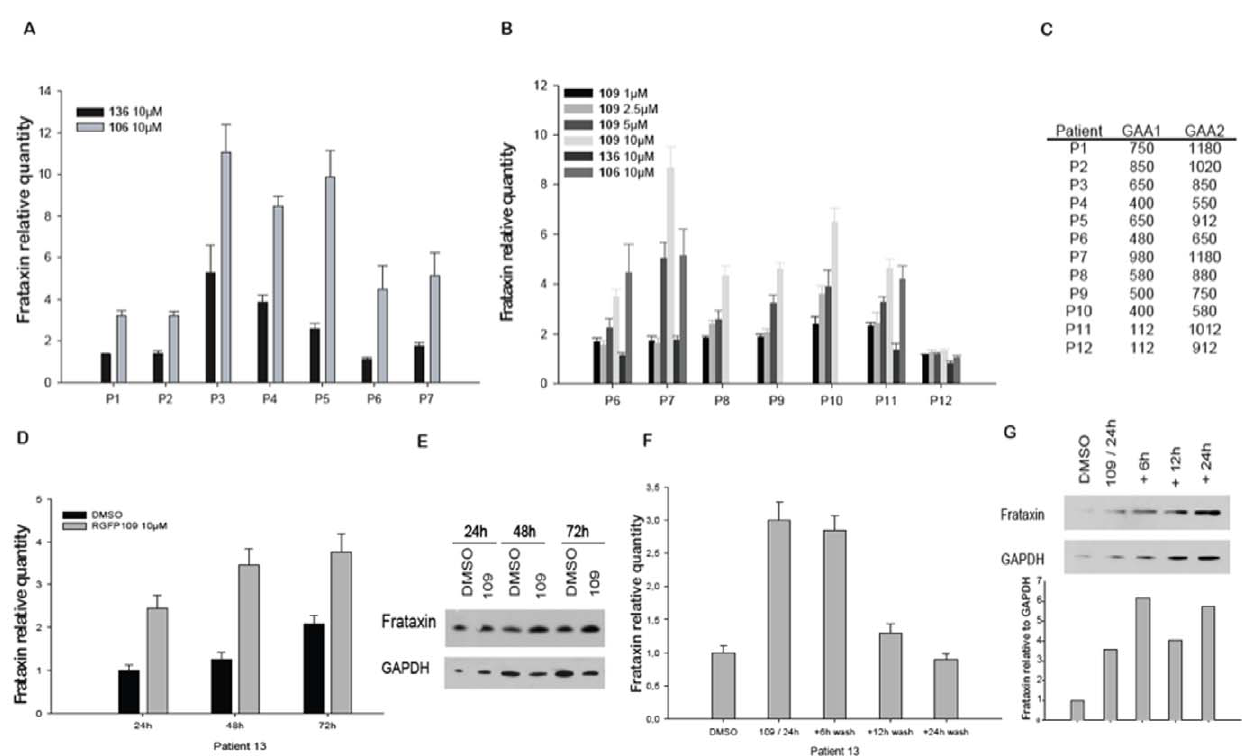
Figure 2. Effect of compounds 136 and 109 on FRDA patients’ primary lymphocytes. A. FXN mRNA levels were measured in RNA from isolated PBMCs from patients (P1–P7) after a 48-hour incubation with either 136 or 106 at 10 m M or DMSO (at 0.1%). Quantitative real-time RT-PCR was used to determine relative FXN levels for each patient condition using GAPDH as a control housekeeping gene. DMSO condition was set to value 1 for each patient. Error is represented as the standard deviation of the mean from 3 determinations. p , 0.001 in all tested patients with compound 106 . Primary lymphocytes were obtained from donor blood from FRDA patients as described [8]. B. FXN mRNA measurement by quantitative real- time RT-PCR in RNA from isolated PBMCs from patients (P6–P12) after a 48-hour incubation with 109 at 1, 2.5, 5 or 10 m M, or 106 at 10 m M or or 136 at 10 m M or with DMSO (at 0.1%) as control. DMSO condition was set to value 1 for each patient, with GAPDH as reference gene. p , 0.001 for P6-7 with compound 109 at 5 and 10 m M and with compound 106 ; p , 0.001 in all conditions for P8-P11 except for P11 condition with compound 136 ; p , 0.001 for P12 only with compound 109 at 10 m M only. C. Representative table of GAA repeat size in tested patients samples. D. PBMCs from patient P13 were treated with either 109 at 10 m M or DMSO for 24, 48 or 72 hours before harvesting. FXN mRNA was determined by quantitative real-time RT-PCR, relative to GAPDH. E. Protein extracts were prepared from harvested cells from panel D. treated with DMSO or 109 , and subjected to western blotting with frataxin or GAPDH antibodies. F. Another extraction of PBMC from patient P13 were treated with either 109 at 10 m M or DMSO for 48 hours and harvested after a 6, 12 or 24 hours wash out period. FXN mRNA was determined by real-time RT-PCR and in G. , frataxin protein was assessed by western blotting followed by densitometry quantification after the same time points for wash